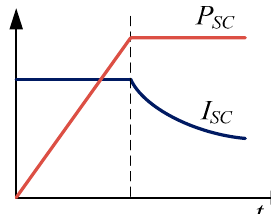
Figure 10. Supercapacitor (SC) charging method.